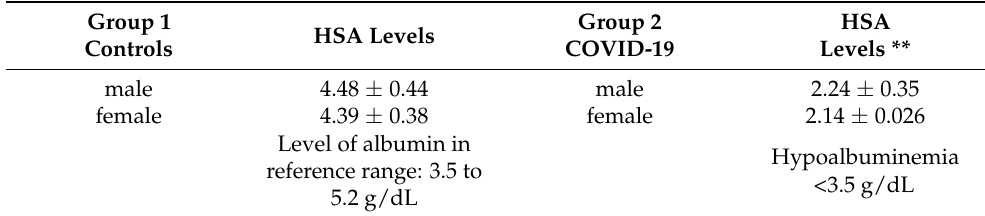
Table 2. Clinical data of serum albumin levels in clinically healthy volunteers—control group (Group 1) and in patients with COVID-19 (Group 2). The results showed a statistically significant difference ( p < 0.05) between COVID-19 patients, controls, and the reference range. The presented data on serum albumin levels (mean ± SE) measured between 24 and 48 h before exitus in COVID-19 patients